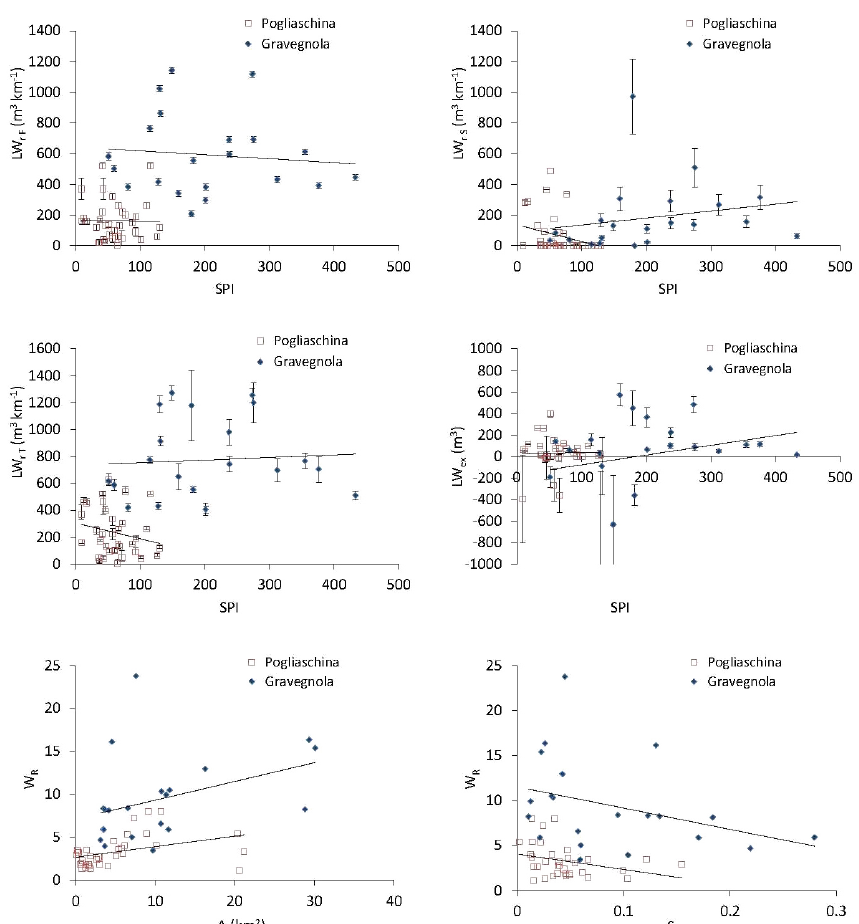
Figure 9. Relationships between selected control factors (SPI = Stream Power Index) and LW variables (LW r F = LW recruitment rate in the fluvial corridor; LW r S = LW recruitment rate in the hillslopes; LW r T = LW recruitment rate in both, fluvial corridor and hillslopes; LW ex = LW exported). The relationship between widening ratio ( W R ) and drainage area ( A ) and channel slope ( S ) is shown too. The error bars express the uncertainty deriving from the range of assumptions for the estimate of LW volumes (see methods).